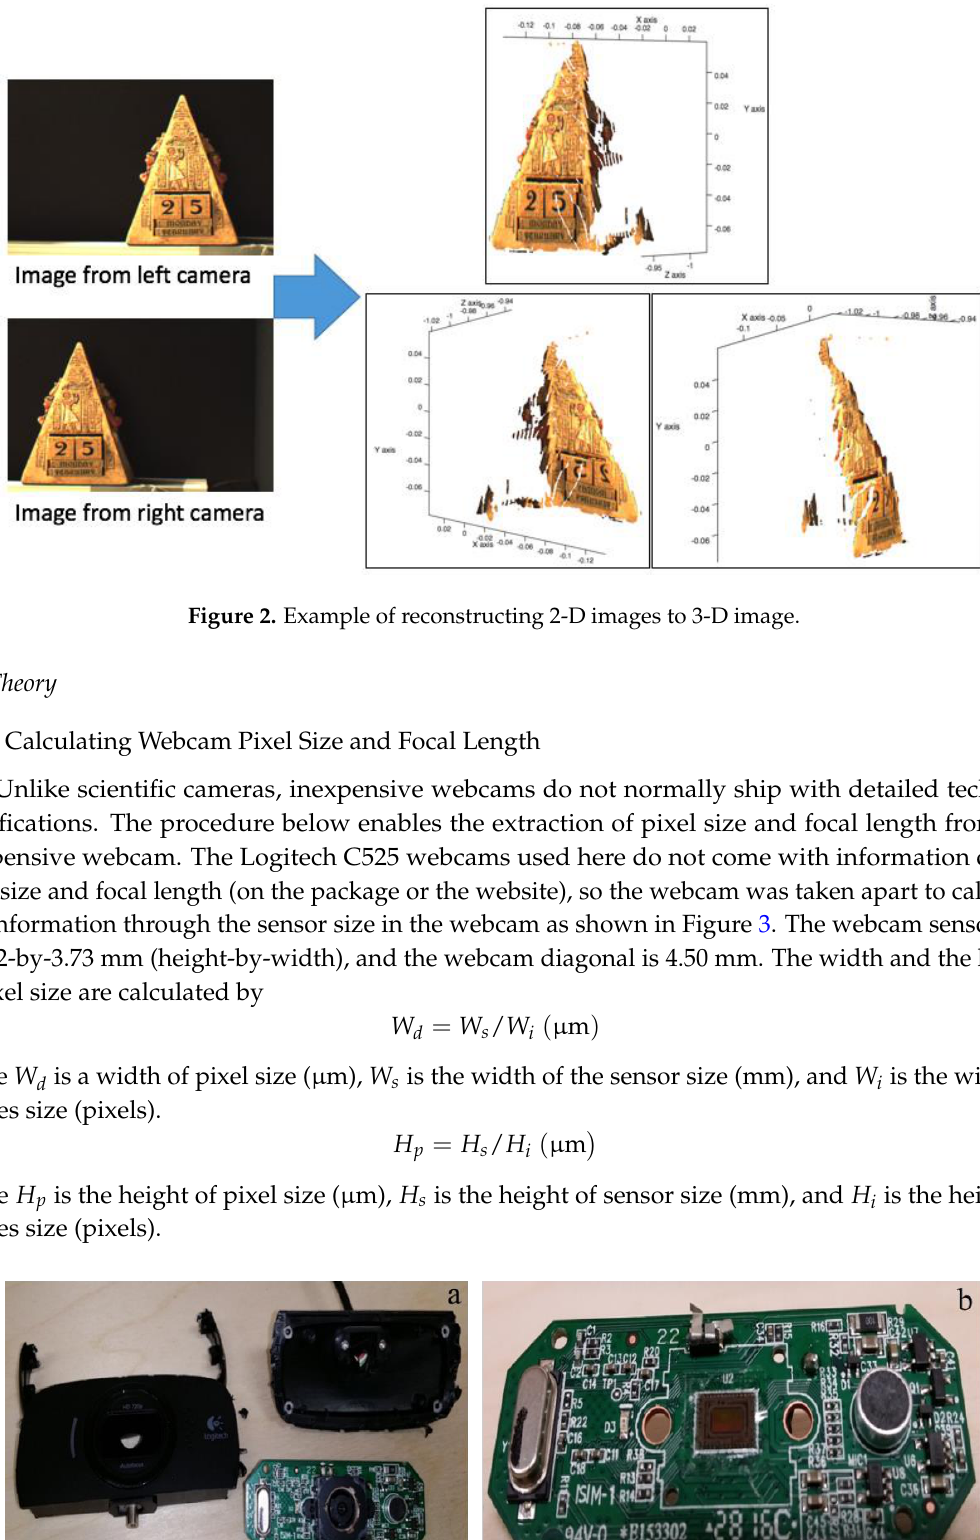
Figure 4. Example of the checkerboard image where the square size is 7-by-7. 2.2.2. Computer Vision Error Detection There are three steps to prepare the error detection system before printing a 3-D model: (1) camera calibration, (2) preparing STereoLithography (STL) files and resultant images, and (3) setting up a pause and loop to move the extruder out of the view of the cameras for imaging. STL file is a file format describing 3-D model by using series of connected triangles to create the surface of the model and it is usually generated by computer-aided design (CAD) software. The first step is camera calibration. Sixteen chessboard (Figure 4) images are taken from three different views of the cameras after the 3-D printer experiment is setup for camera calibration. There are six cameras named as camera0, camera1, camera2, camera3, camera4, and camera5. The camera0 and camera1 are setup as the first pair of cameras, camera2 and camera3 are setup as the second pair, and camera4 and camera5 are setup as the third pair. The camera0, camera2, and the camera4 are setup as the left cameras, and camera1, camera 3, and the camera5 are setup as the right cameras. The calibration is calculated and saved as CalibrationData1, CalibrationData2, and CalibrationData3. The second step is preparing the stlimage by slicing stl files every N layers where the error will be detected as shown in Figure 5. The layer height and the amount of slicing layers need to be assigned for slicing stl file in three different views of the cameras. The layer height and the number of total layers can be found in gcode file. All data at every N layers from the stl file are plotted in x, y, z axes to display the shape of the rendered 3-D model, which can be observed from different viewpoints. The shape of the stlimage is saved as PNG image type on xz-plane. If a remainder after division between the total height and the height of every N layers is not equal to zero, the last PNG files are named as the amount of total layers. For example, if the 3-D model in gcode file has 129 total layers, layer height of 0.2 mm, and the 3-D model is slicing in every 30 layers, then the stl file is sliced at layer 30, 60, 90, 120, and 129 which result in